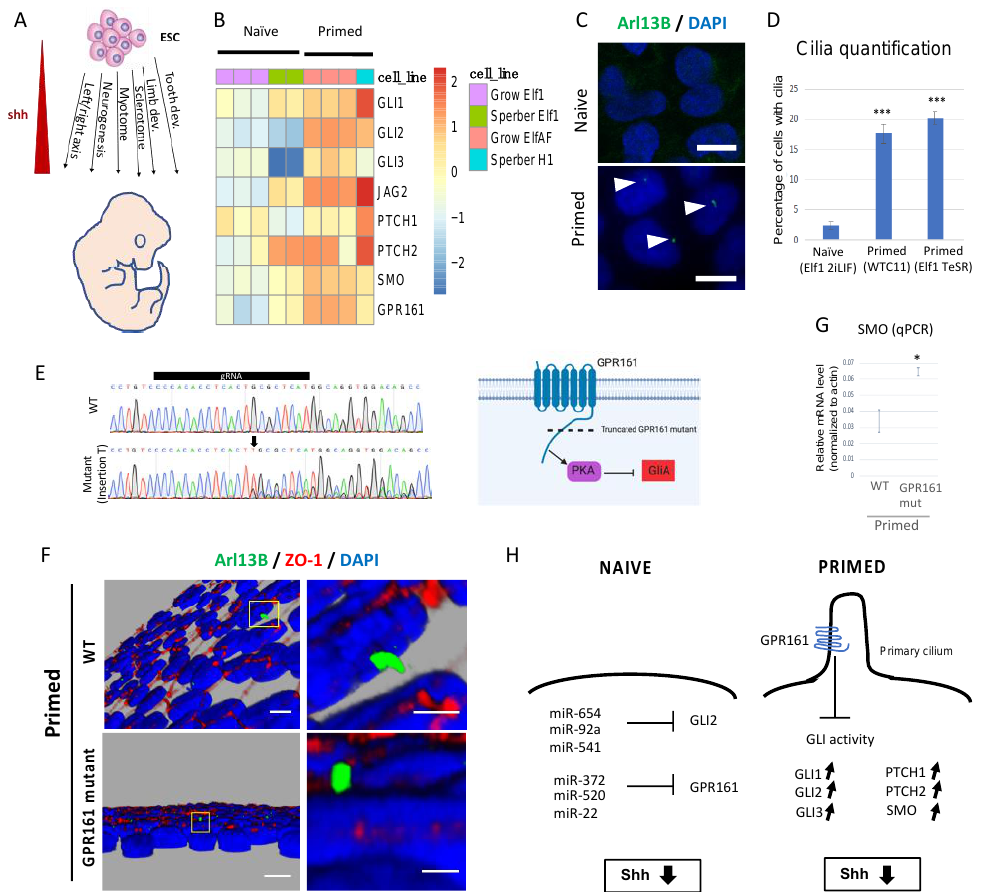
Figure 2. The Hh pathway in naïve-to-primed transition: ( A ) Schematic representation of the role of shh pathway during early development. Shh pathway is not active in ESC but plays an important role in various developmental processes. ( B ) Expression of shh pathway components in naïve hESC (Elf1 2iLIF, Sperber et al. and Grow et al.) and primed hESC (Elf1 AF, Grow et al. and H1 Sperber et al.). ( C , D ) Cilia are present only in primed hESC, not in naïve hESC, as visualized by Arl13B staining in naïve (Elf1 2iLIF) and primed (Elf1 TeSR) hESC. Scale bars represent 5 µ m, triangles indicate the presence of primary cilia. Standard Error of Mean (s.e.m); *** p < 0.001; 2-tailed t -test. ( E ) Sanger sequencing results of the GPR161 gene around the gRNA in Elf1 wild type (WT) and GPR161 mutant show an insertion of the nucleotide T, resulting in a frame shift and premature STOP codon ( left panel ). This mutation leads to the generation of a truncated GPR161 protein missing the functional C terminus domain responsible for regulation of PKA and shh activity ( right panel ). ( F ) Cilia (ARL13B) immunofluorescence staining in Elf1 WT and Elf1 GPR161 mutant grown in primed conditions (TeSR). On the right side are high magnification images of the boxed regions shown on the left side. Scale bars represent 5 µ m. ( G ) Shh component SMO is up-regulated in Elf1 GPR161 mutant cells compared to WT in primed conditions (qPCR analysis). S.e.m.; * p < 0.05; 2-tailed t -test. ( H ) Model of repression of shh activity in naïve and primed hESC through microRNAs. T-bars indicate repression, arrow upwards upregulation and downwards